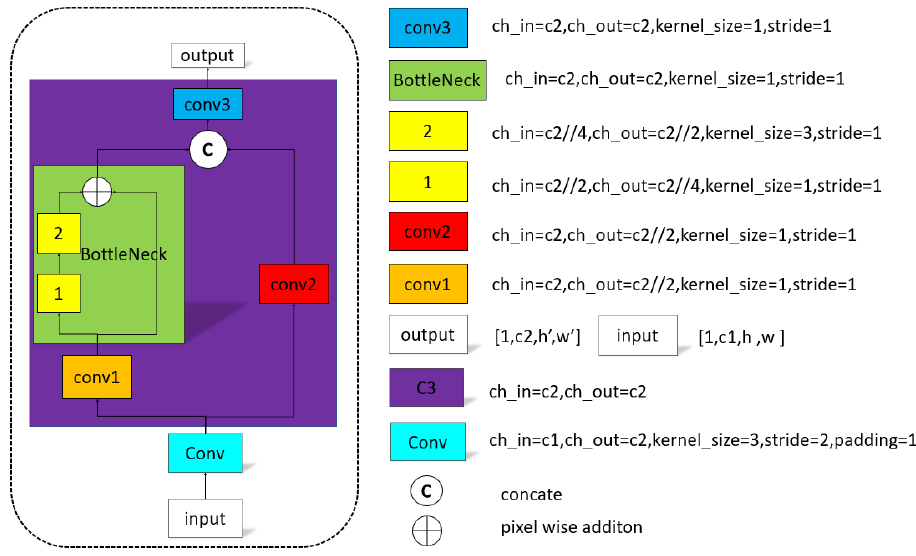
Figure 9. Network structure of YOLOv5.